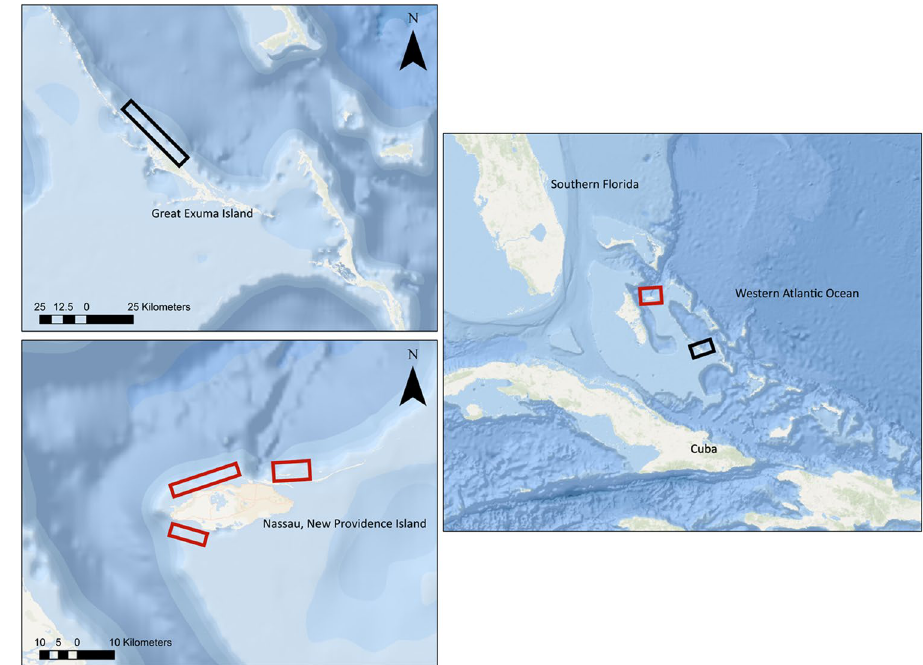
Figure 4. Sampling location of sharks from Great Exuma (black boxes, top left panel) and Nassau New Providence Island (red boxes, bottom left panel), The Bahamas in relation to North Americas and wider western Atlantic Ocean (right panel). Sources: ESRI, GEBCO, NOAA, National Geographic, DeLorme, HERE, Geonames.org, and